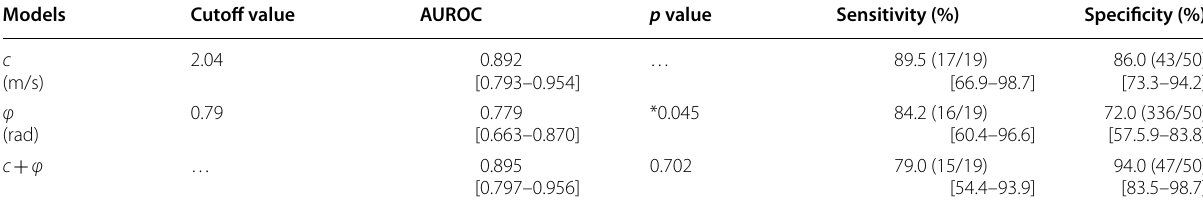
Table 5 Performances of the models in predicting ICG-R15 >